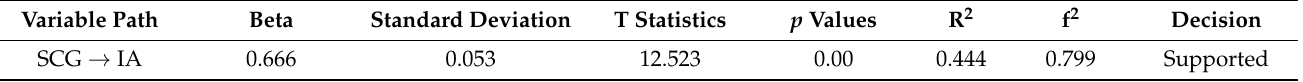
Table 6. Significance of Direct Effect–Path